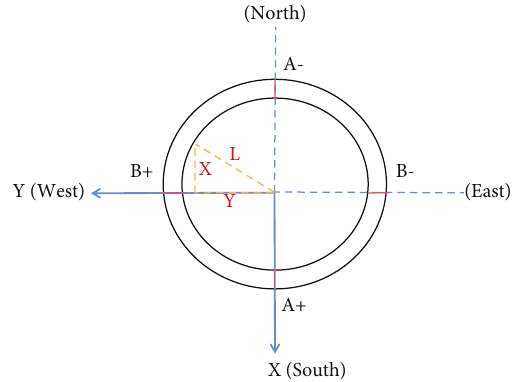
Figure 4: Schematic diagram of combined displacement